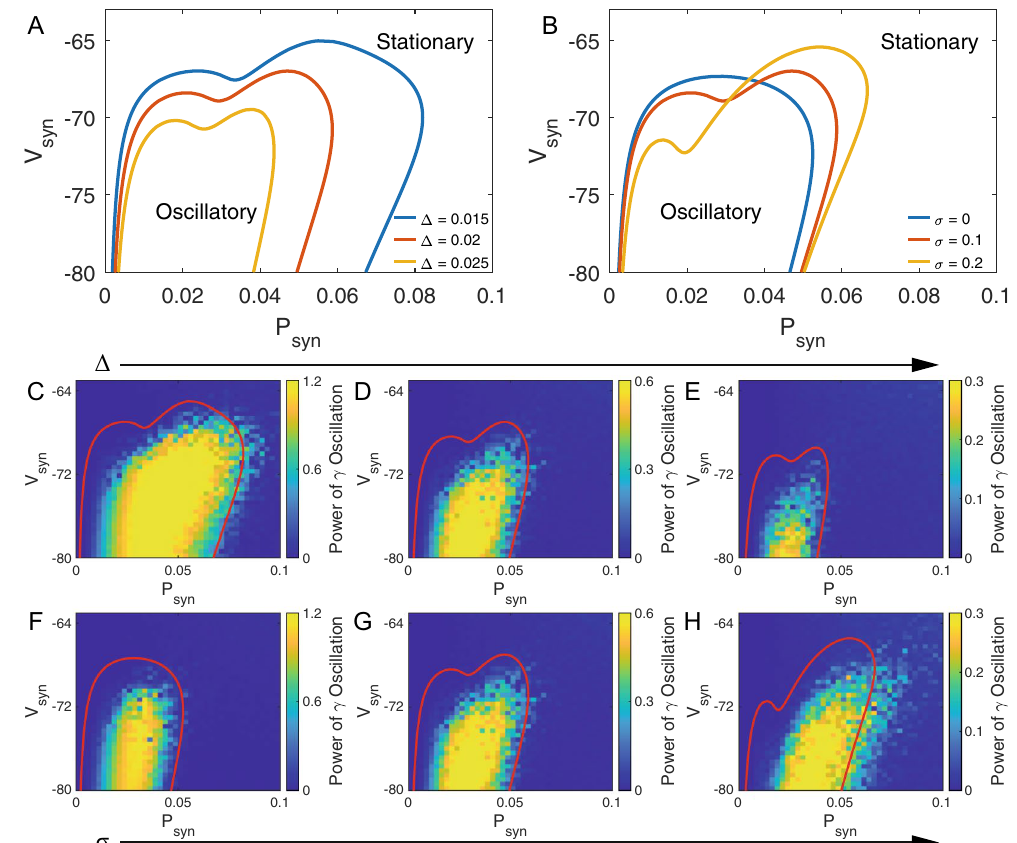
Figure 3. Distinct roles of heterogeneity and noise in ( P syn , V syn ) plane ( A ) Role of heterogeneity in ( P syn , V syn ) plane. Bifurcation diagram of the two-cumulant model [Eqs. (2), (3) and (4)]. The three curves are all plotted under [ η = 0.7, σ = 0.1 ], but with different values of heterogeneity (cid:31) : 0.015 for blue, 0.02 for red, 0.025 for yellow. ( B ) The role of noise in the ( P syn , V syn ) plane. The three curves are all plotted under [ η = 0.7, � = 0.02 ], but with different values of magnitude of noise σ : 0 for blue, 0.1 for red, 0.2 for yellow. ( C )–( E ) Validation of increasing (cid:31) . ( F )–( H ) Validation of increasing σ . All bifurcation diagrams of macroscopic model are plotted with XPPAUT 37 . All numerical simulations of the microscopic model are generated by MATLAB (2019b, http:// www. mathw orks. com/ produ cts/